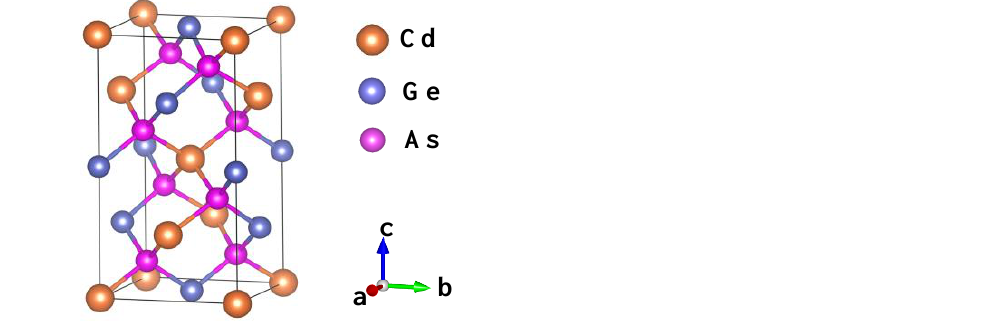
Figure 1. The structural model of CdGeAs 2 (orange sphere is Cd atom, blue sphere is Ge atom, pink sphere is As atom).